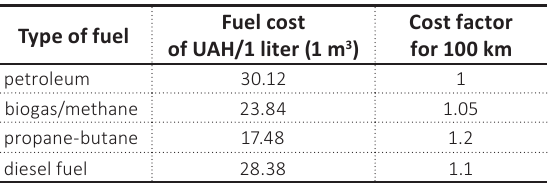
Table 2. Fuel consumption factors for 100 km